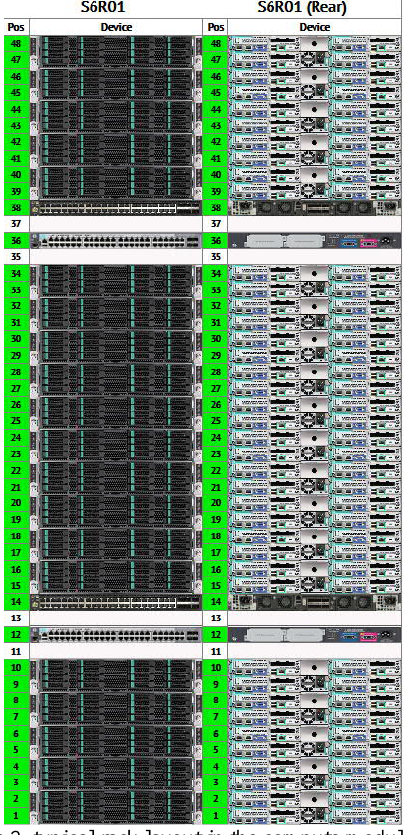
Figure 2: typical rack layout in the compute